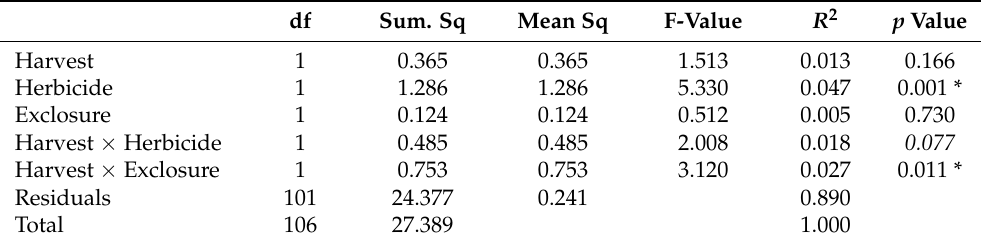
df, degrees of freedom; Sum. sq., sum of squares; Mean sq., mean square.